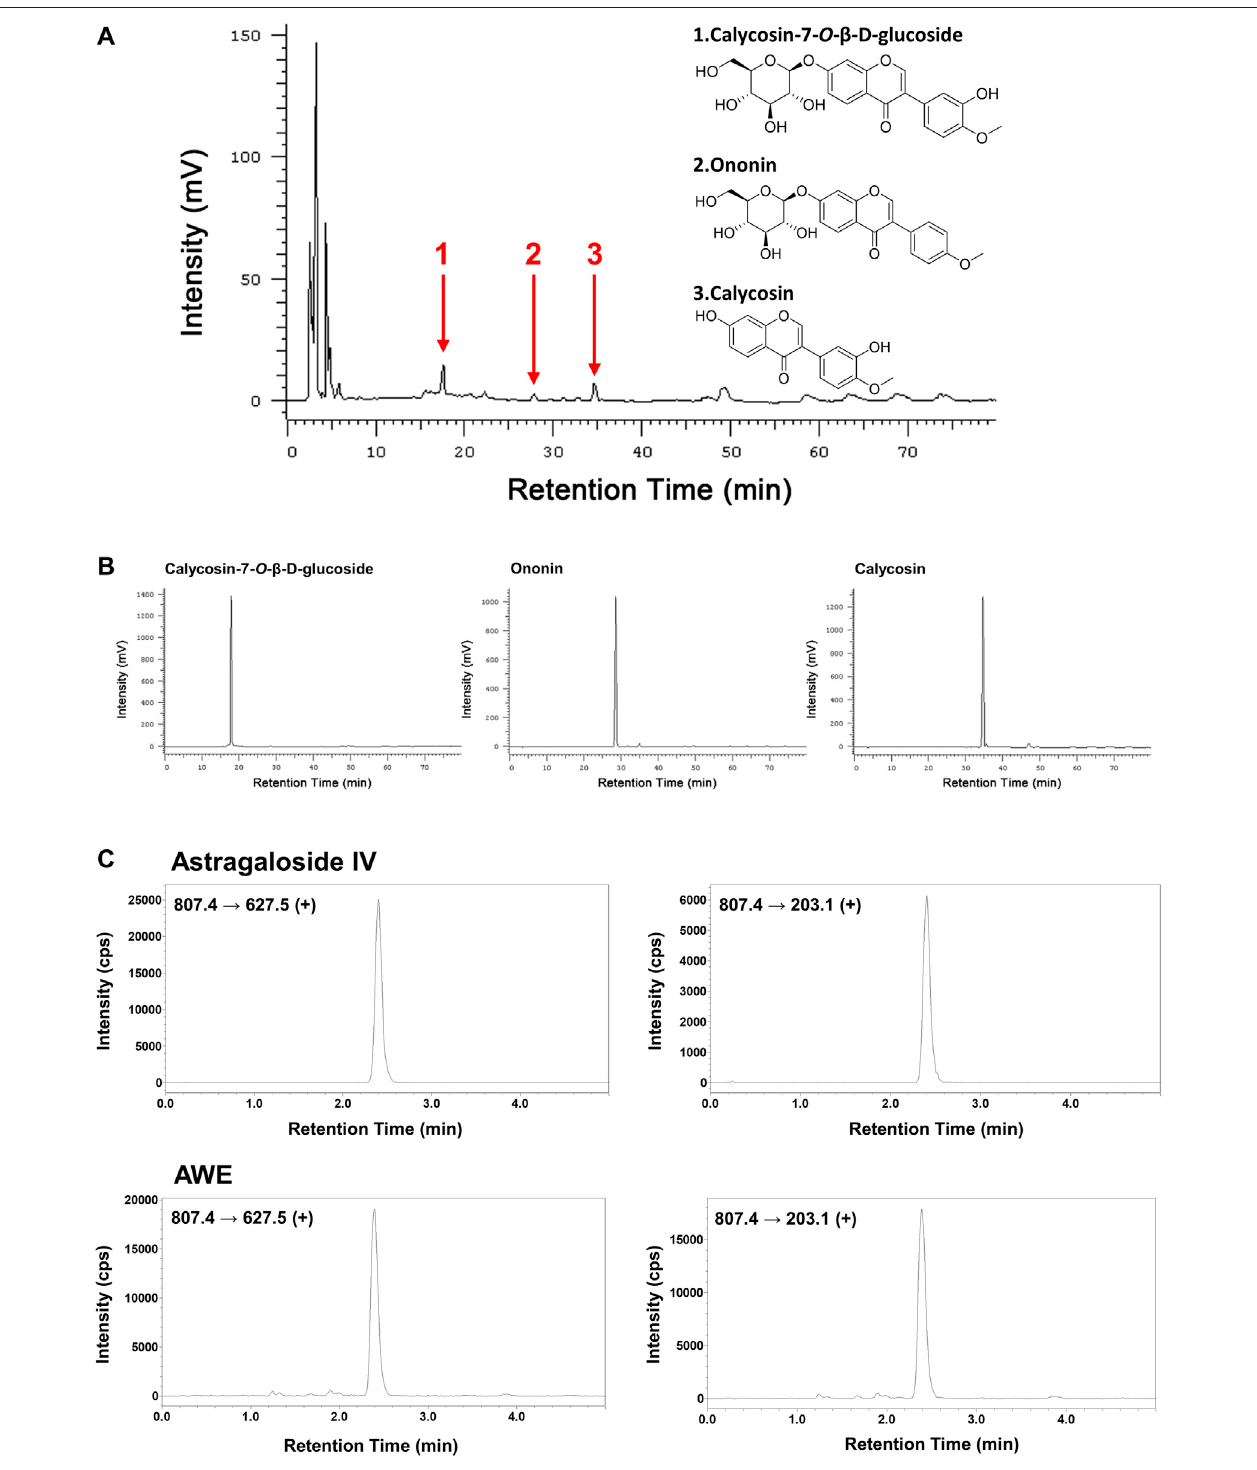
FIGURE 1 | The chemical fi ngerprint of Astragalus mongholicus Bunge water extract (AWE). Chromatograms were obtained from high-performance liquid chromatography (HPLC) at 260 nm. (A) HPLC fi ngerprint of AWE and (B) of three standard references including 1: Calycosin-7-O- β -D-glucoside; 2: Ononin; 3: Calycosin; (C) Identi fi cation of astragaloside IV in AWE using ultra-performance liquid chromatography-tandem mass spectrometry (UPLC-MS/MS). (D) Structures of the parent ion and product ions of astragaloside IV.